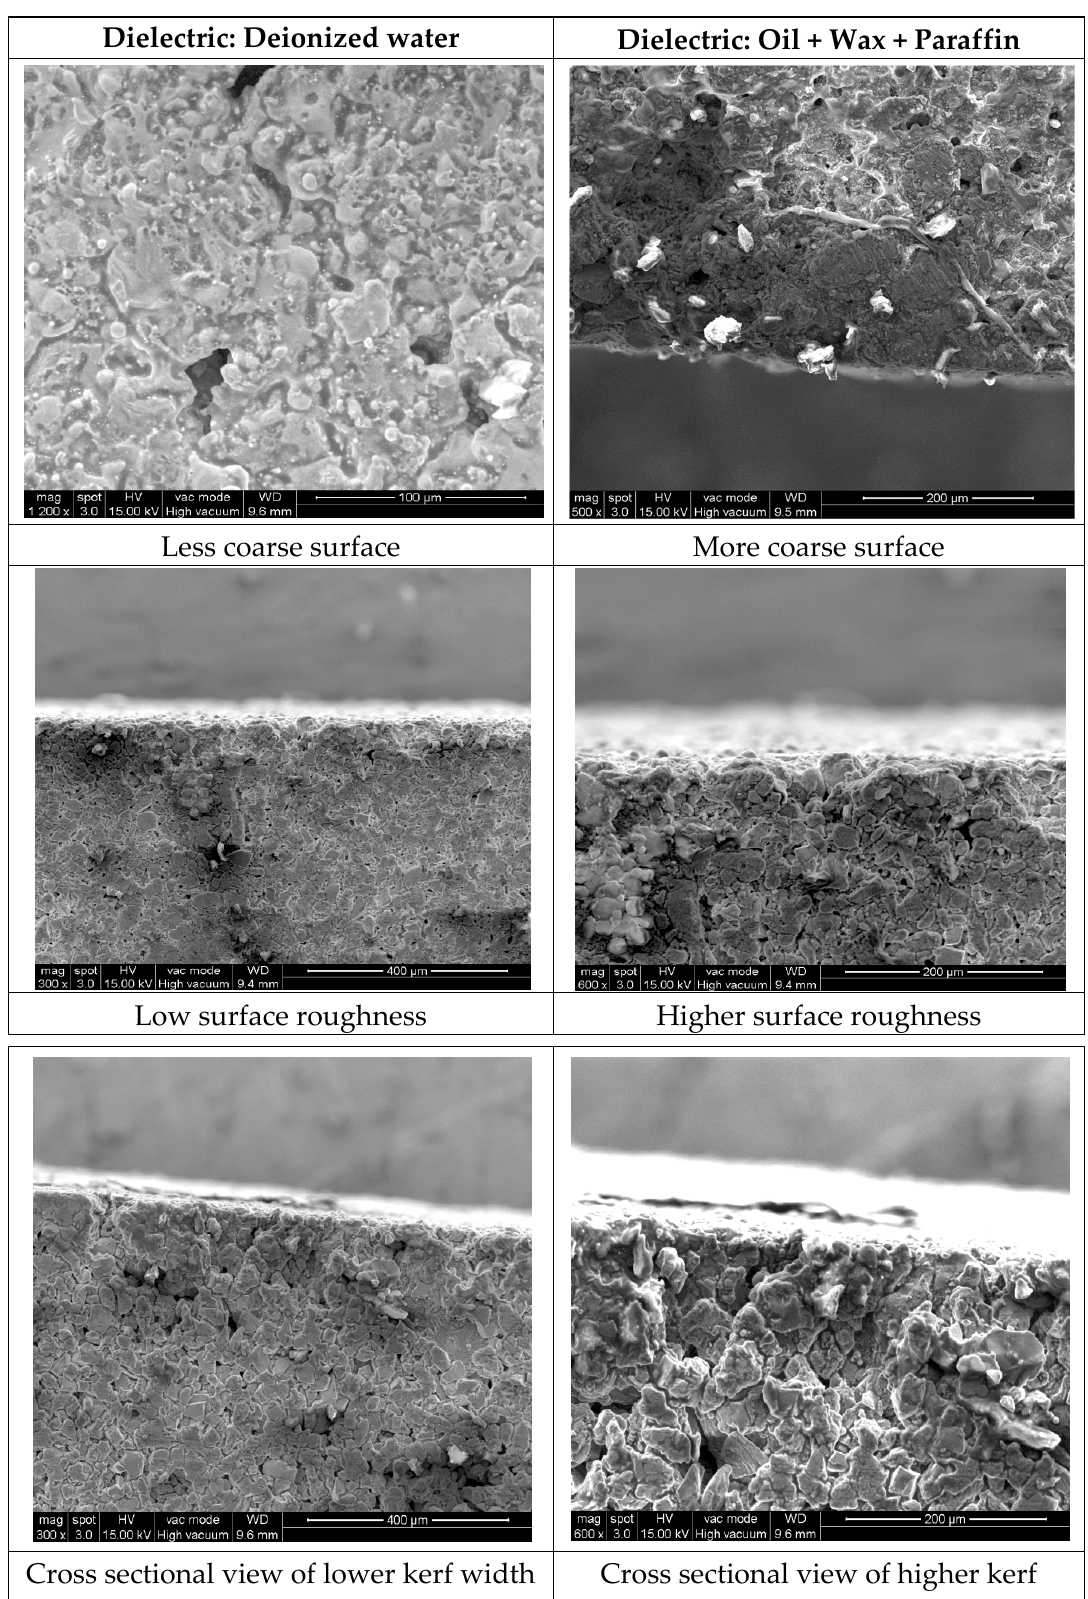
Figure 11. Surface morphology of the wire electrical discharge machined Al-SiC-TiC metal matrix composite. The factor of roughness in the presence of OWP dielectric surged drastically, due to the latent heat being higher as indicated in the cross sectional view figure of kerf width. With the kerf width increase, large craters inside the surface were formed during the removal of material and with a simultaneous surge in the energetic pulse values a higher surface roughness factor was induced on the machined WEDM sample in correlation to the deionized water dielectric medium [21]. The factor of roughness was controlled with the amount of material removal and also the pausing time (T off ) as T off surged the gap and ensured the flow of debris is smoother as a drop in the latent heat of fusion was ascertained in the machining zone [16]. 3.4. Residual Stress The residual stress measurement was carried out by the PANalytical X-Pert Pro materials research unit, and corresponding SEM images indicated were obtained by JSM-6610LV (JEOL, Akishima, Tokyo, Japan). The factor of residual stress in the OWP surged by 32.28% as indicated in Table 12 and Figure 12, in correlation to deionized water, as this is attributed to the presence of lower coarse grains in the surface of WEDM machined component as indicated in Figure 13 [24]. Table 12. Residual stress analysis of wire electrical discharge machined Al-SiC-TiC metal matrix composite.